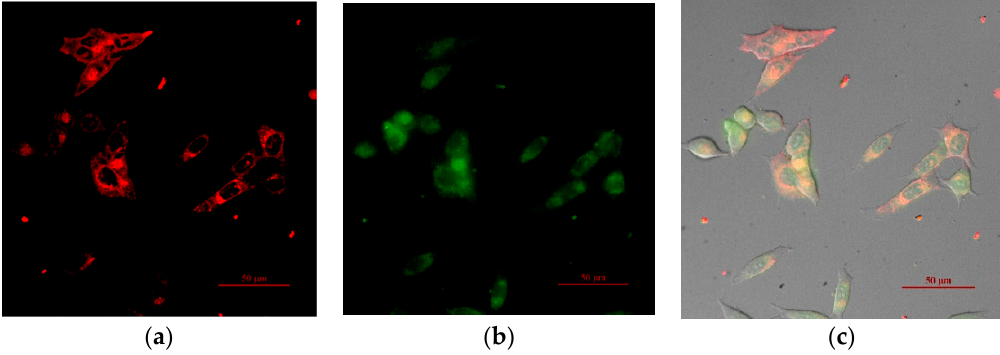
Figure 6. Images of HeLa cells treated with Ru-Tb NPs (30 µ g mL − 1 ): ( a ) red channel, excitation at 488 nm and emission at 585–625 nm; ( b ) green channel, excited by mercury lamp and emission at 525–565 nm; ( c ) overlay of red and green channels, together with the DIC image. In a merged picture, colocalization of red and green signal results in orange areas. Scale bar = 50 µ m.